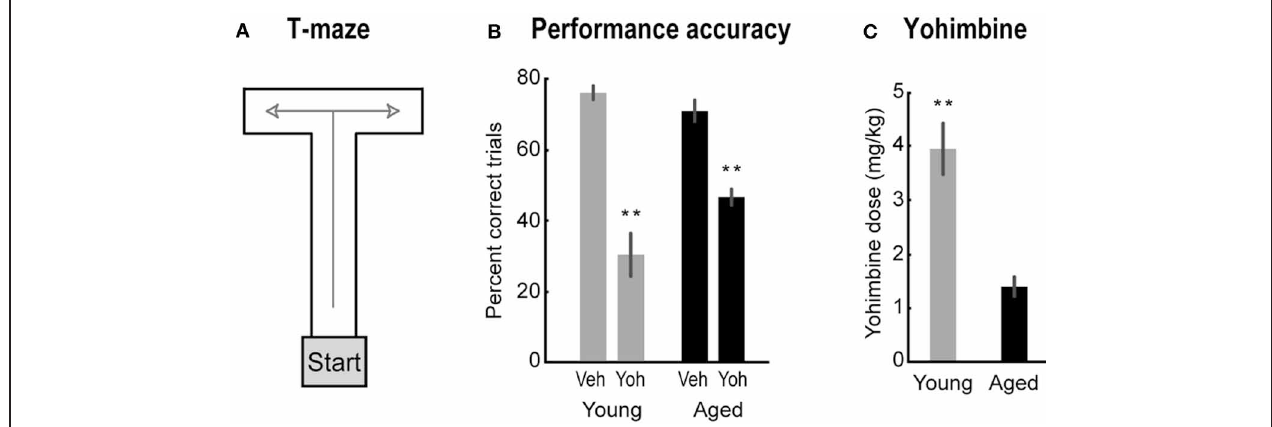
t ( 6 ) = 8 . 65, p < 0 . 001 for young rats. (C) Lowest dose of yohimbine to impair performance. One-Way ANOVA, F ( 1 , 14 ) = 29 . 88, p < 0 . 001. Error bars are SEM. ∗∗ Denotes p < 0 .